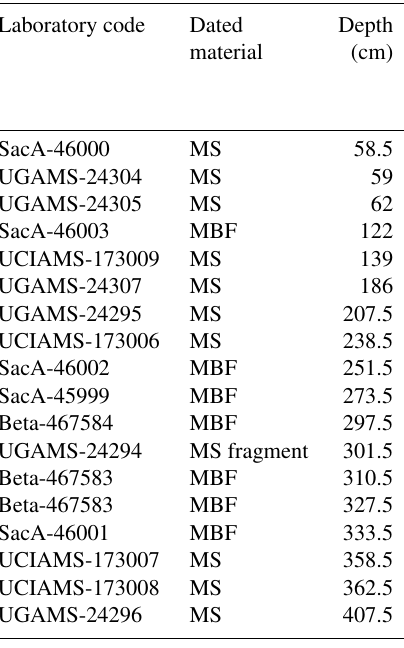
Figure 4. Core AMD14-Kane2b age model (a) and sedimentation rates (b) . The age model is a smooth spline computed using CLAM 2.2 with a smoothing level of 0.4 based on selected radiocarbon dates presented in Table 1. 1 σ uncertainty is shown in grey. 14 C ages excluded from the age model (time reversals) are crossed out in red. Table 1. AMS radiocarbon ages on selected carbonate material. Asterisks indicate data that were not used in the age model. MBF: mixed benthic foraminifera, MS: unidentified mollusc